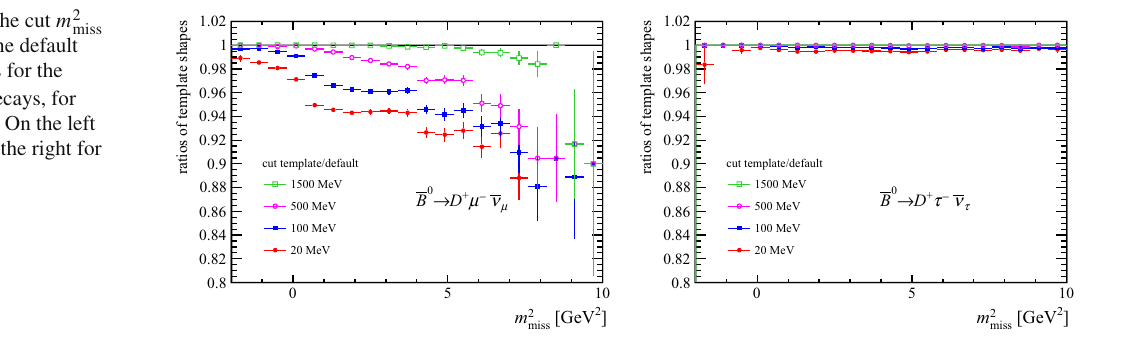
Fig. 4 Shapes of the q 2 , m 2 , and E μ distributions after applying basic selection requirements and the rest frame approximation for the miss B 0 → D + (cid:2) − ν (cid:2) decays where (cid:2) − = μ − ,τ −